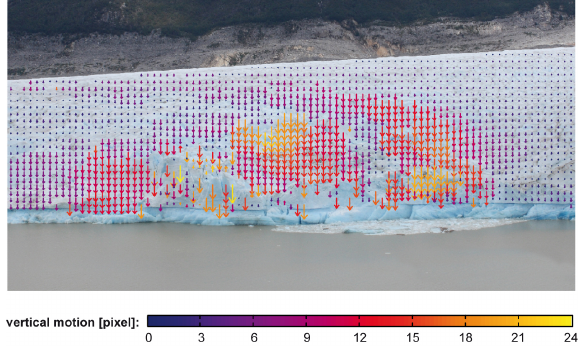
Figure 5. Vertical glacier displacement vectors in image